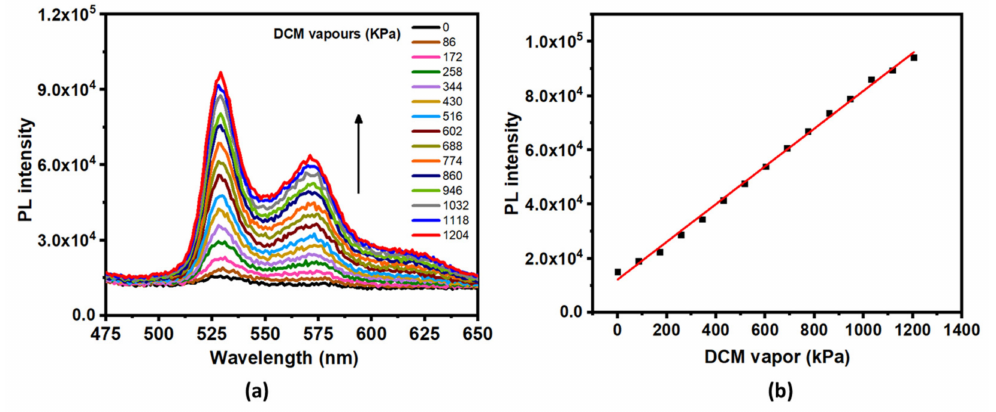
Figure 5. ( a ) PL spectra of M1 (powdered in solid sample holder) with gradually increasing DCM va- por concentration excited at 360 nm, ( b ) Plot between PL intensity of M1 vs. DCM vapor concentration (Pearson’s r value =